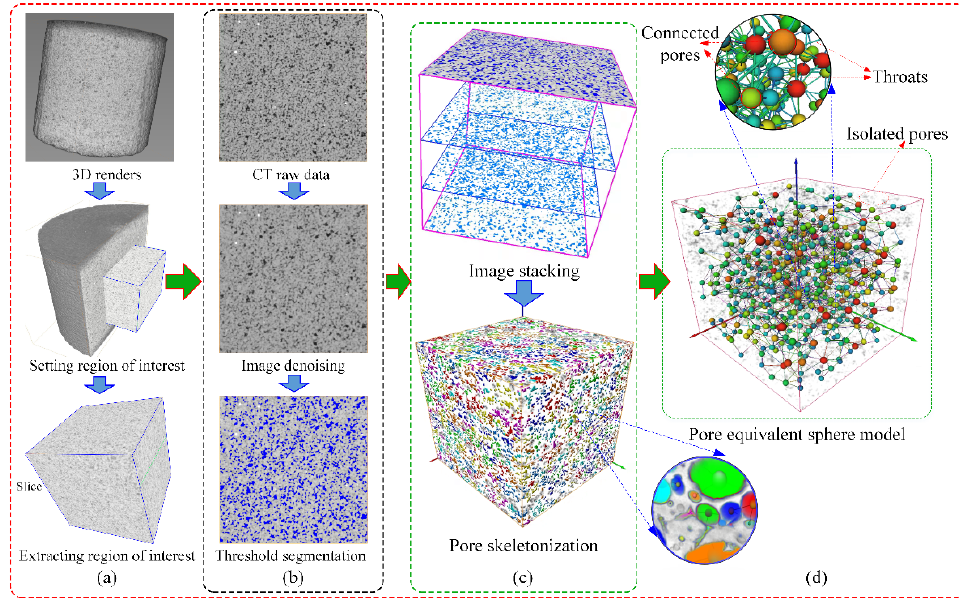
Figure 7. CT image processing and reconstruction process. ( a ) Region of interest; ( b ) 2D image processing; ( c ) 3D reconstruction; ( d ) PNM model.